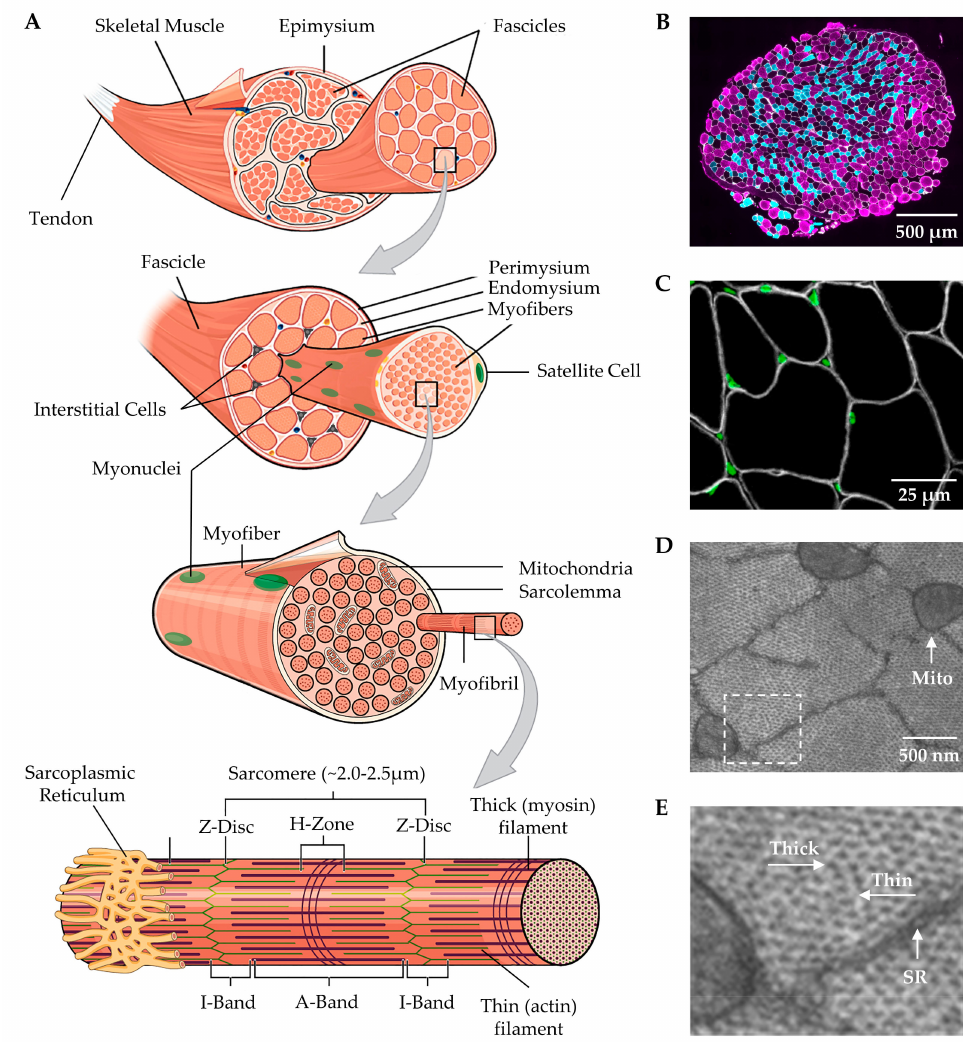
Figure 1. ( A ) Illustration of skeletal muscle structure copied with permission under the Creative Commons Attribution 4.0 International license and adapted for this review, available online: https: // openstax.org / books / anatomy-and-physiology / pages / 10-2-skeletal-muscle (accessed on 6 January 2020) [28]. ( B ) Cross-section of a mouse plantaris muscle that was subjected to immunohistochemistry for the identification of Type IIA (cyan), and Type IIB (magenta) myofibers as well as laminin to identify the endomysium (white). ( C ) Cross-section of a mouse plantaris muscle that was subjected to immunohistochemistry for the identification of dystrophin to identify the inner boundary of the sarcolemma (white) and nuclei (green). ( D ) Cross-section of a mouse plantaris muscle that was subjected to electron microscopy to highlight the sarcoplasmic reticulum (SR) that surrounds individual myofibrils as well as the mitochondria (Mito) that run between the myofibrils. ( E ) Higher magnification of the boxed region in D reveals the presence of the thick and thin